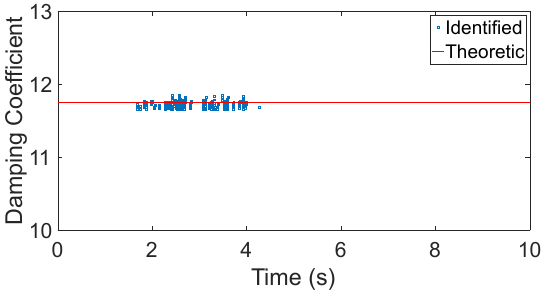
Figure 16. Identified damping coefficient from numerical analysis of bridge model.